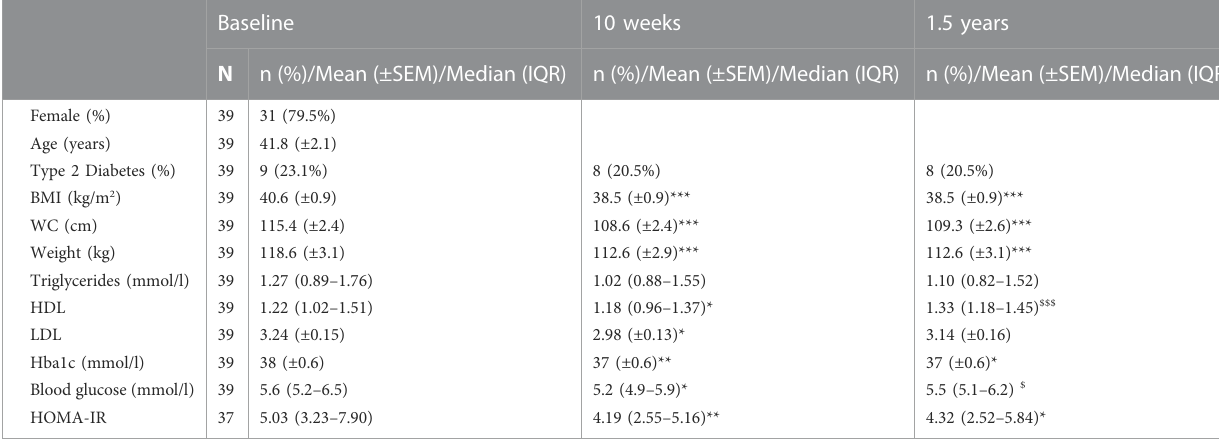
BMI = body-mass-index, WC = waist circumference; HDL = high-density lipoprotein; LDL = low-density lipoprotein; HOMA-IR = Homeostatic Model Assessment for Insulin Resistance. *** p < .001, ** p < .01, * p < .05 indicates signi fi cant difference compared to baseline; $ $ $ p < .001, $ p < .05 indicates signi fi cant difference compared to 10 weeks. Tested using Bonferroni- corrected repeated-measurements